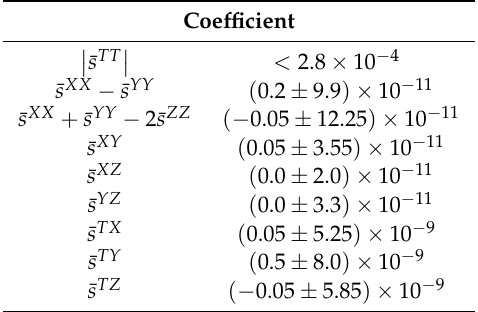
Table 6. Estimation of SME coefficients from binary pulsars data analysis from [53,54]. No correlations coefficients have been derived in this analysis. These estimates should be considered as estimates on the strong field version of the SME coefficients that may include non perturbative strong field effects due to the gravitational binding